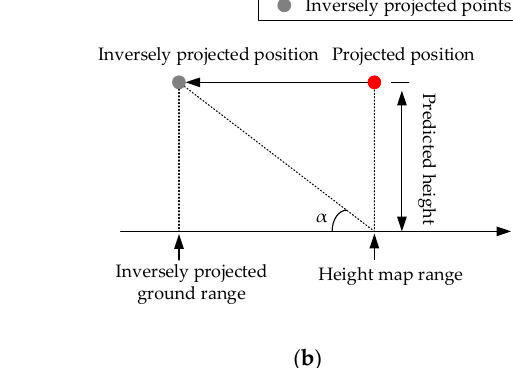
pointsLine of sight